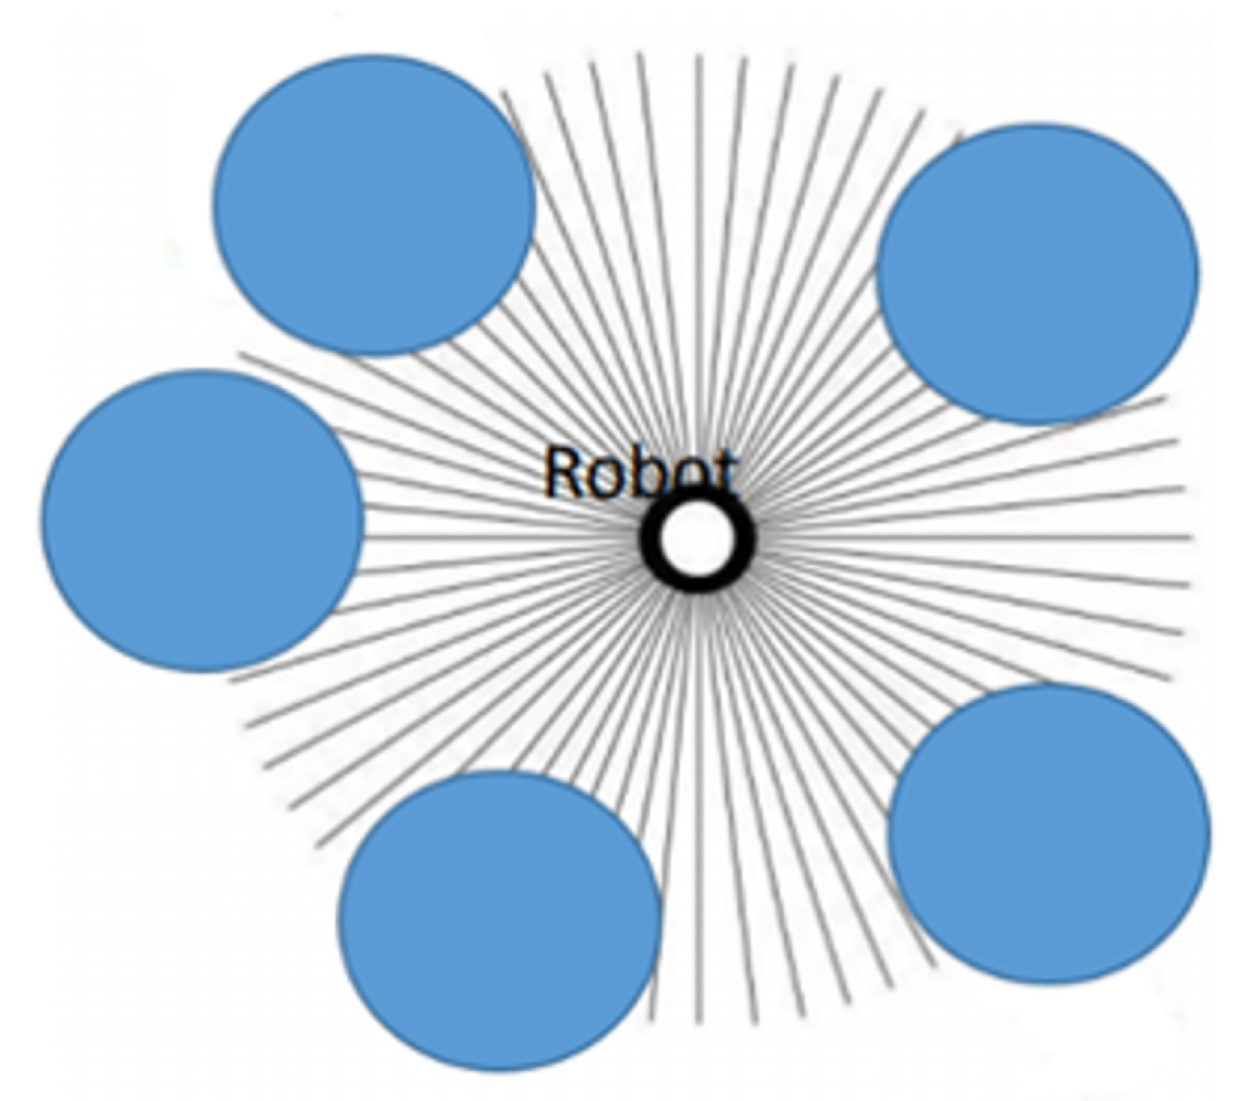
Fig 4. Movement directions of the